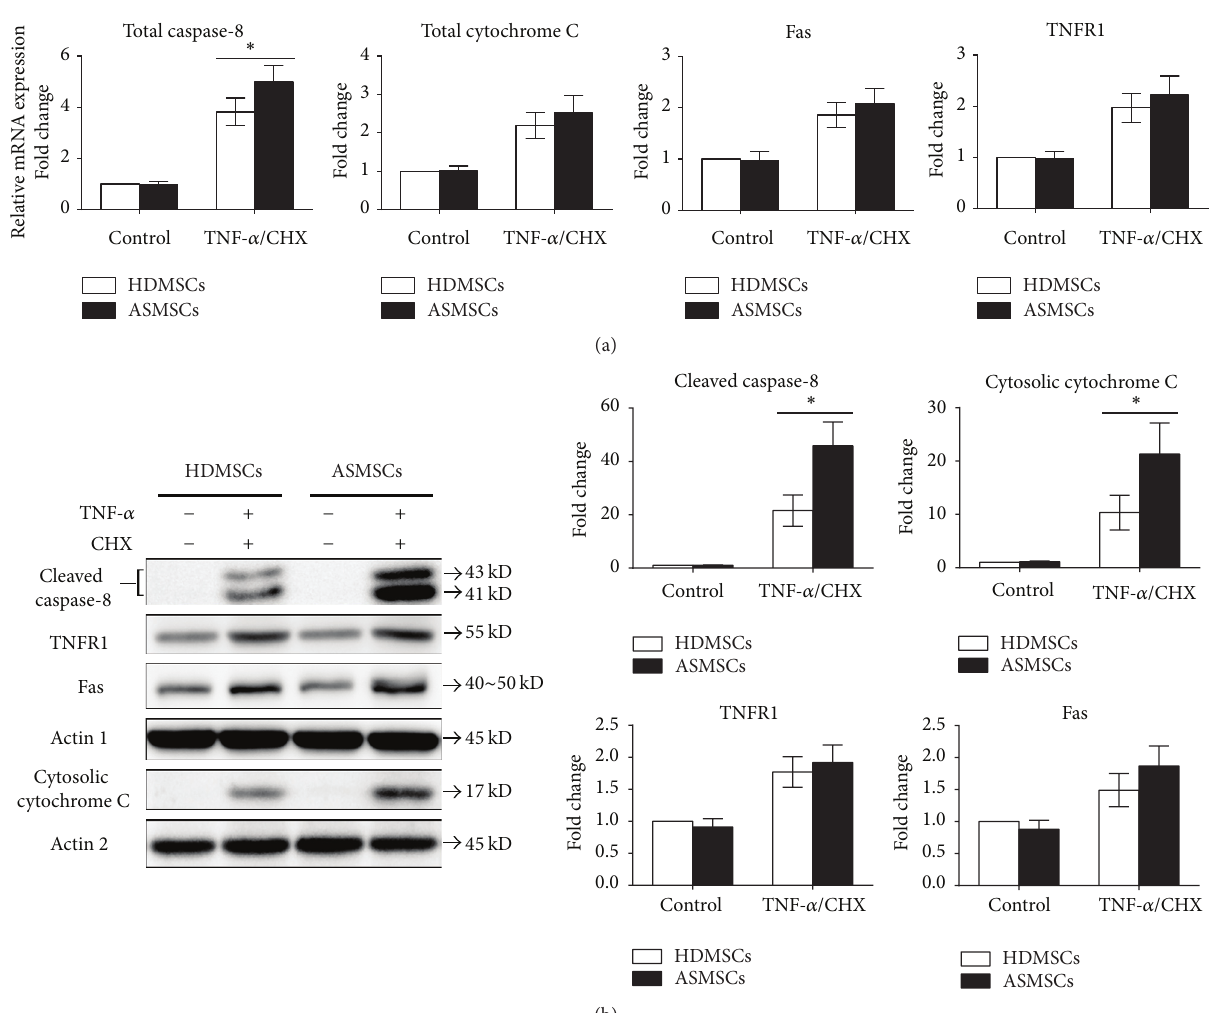
Figure 4: The DR and mitochondrial pathways were both involved in MSC apoptosis. (a) qRT-PCR was performed to compare the gene expressions of total caspase-8, total cytochrome C, Fas, and TNFR1 between HDMSCs ( 𝑛 = 28 ) and ASMSCs ( 𝑛 = 22 ). ASMSCs expressed muchhighergeneexpressionlevelsoftotalcaspase-8thanHDMSCsaftertreatmentwithTNF- 𝛼 /CHX,whilenodifferencewasfoundbetween HDMSCs and ASMSCs in total cytochrome C, Fas, or TNFR1 gene expression levels. (b) A western blot was performed to compare the protein expressions of cleaved caspase-8, cytosolic cytochrome C, TNFR1, and Fas between HDMSCs ( 𝑛 = 28 ) and ASMSCs ( 𝑛 = 22 ). After treatment with TNF- 𝛼 /CHX, ASMSCs had higher cleaved caspase-8 and cytosolic cytochrome C protein expression levels than HDMSCs and similar protein levels of TNFR1 and Fas as HDMSCs. Fold changes are presented as the mean ± SD. ∗ indicates 𝑃 < 0.05 between HDMSCs and